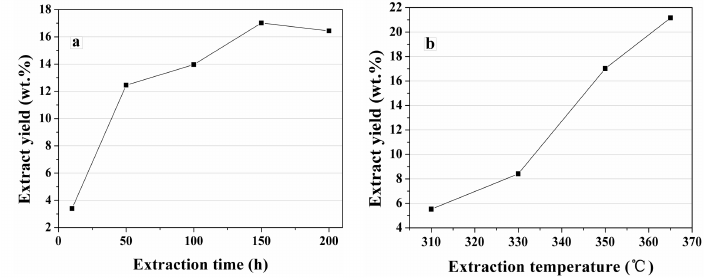
Figure 2. Yield of bitumen extracted by sub-critical water at ( a ) 350 ◦ C and ( b ) 150